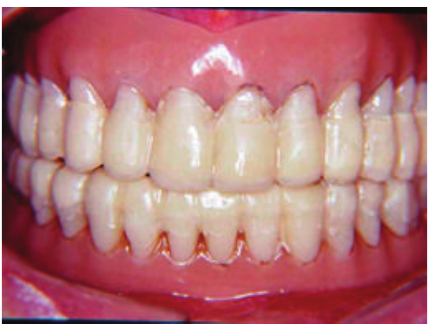
Figure 5: Installation of the mandibular occlusal splint after a 30- day period of adaptation.